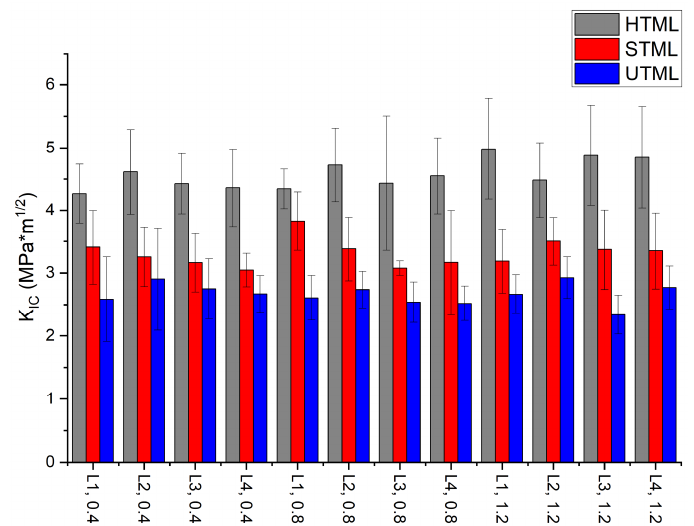
Figure 3. Fracture toughness K Ic ín MPa√m for multilayer samples. HTML: Katana™ High Translu- cent Multi-layered zirconia; STML: Katana™ Super Translucent Multi-layered zirconia; UTML: Katana™ Ultra Translucent Multi-layered zirconia.